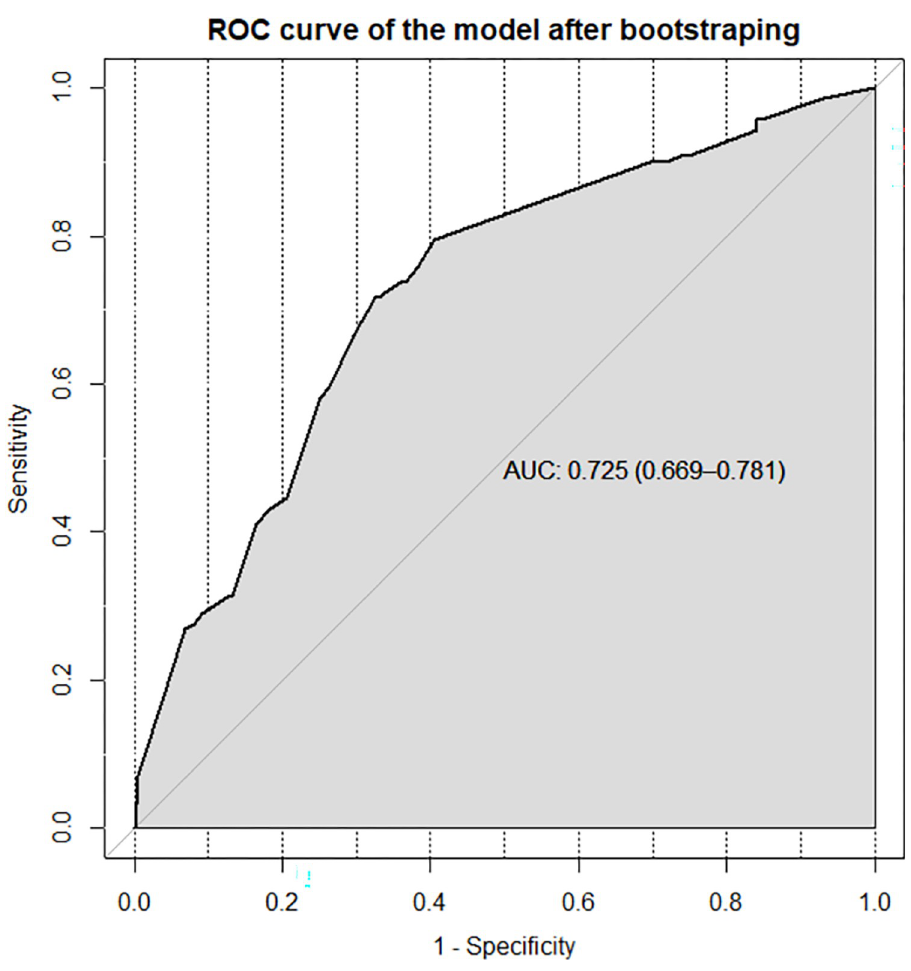
Fig 6. ROC curve of the model after internal validation using the bootstrapping